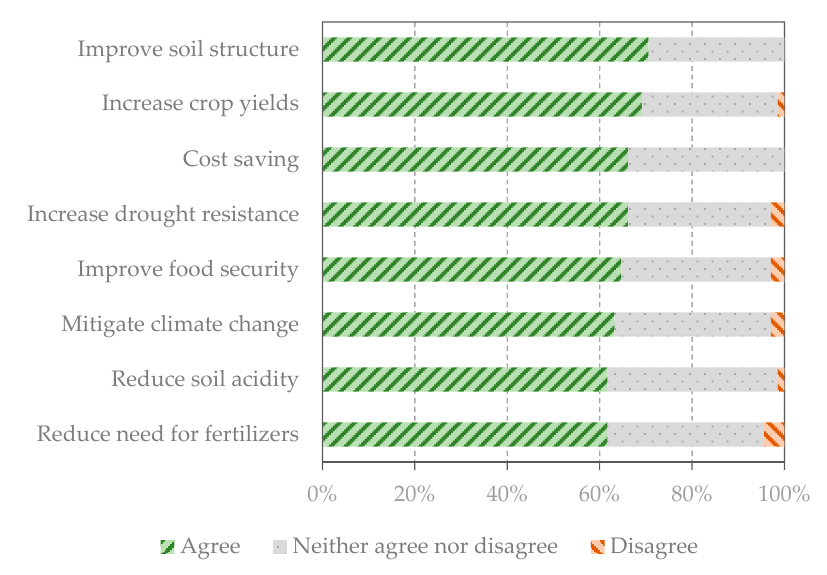
Figure 1. Motives for smallholder farmers, who are informed about biochar ( n = 68), to engage in biochar technology.